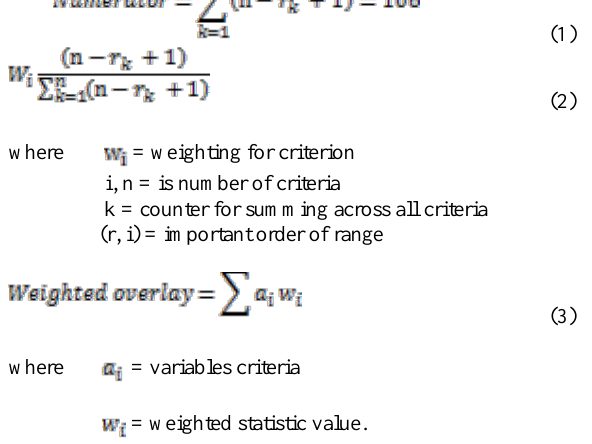
Figure 2. Number of wildfire occurrence in Eastern part of Mongolia